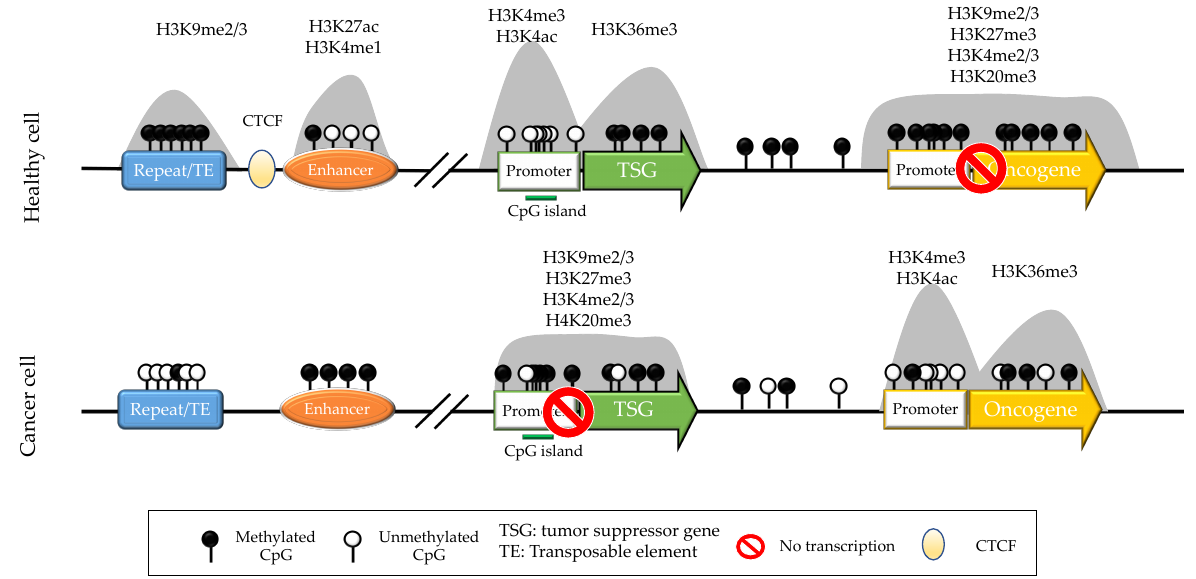
Figure 2. A few selected chromatin marks, their distribution along a portion of the genome, and their alteration in cancer